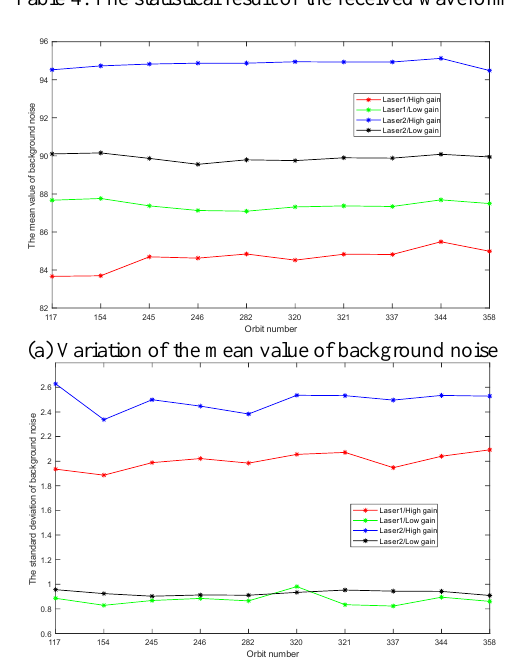
Table 4. The statistical result of the received